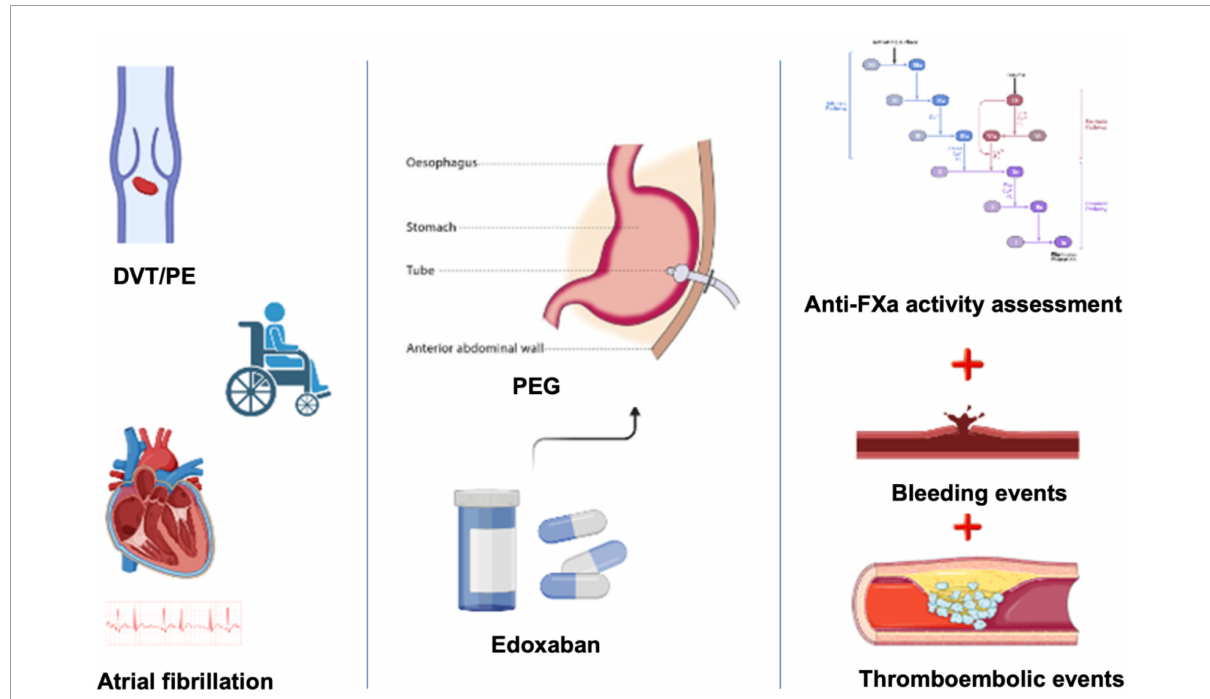
FIGURE1 The main features of the ORIGAMI study design. Patients with indication for long-term oral anticoagulation indication were enrolled; edoxaban (at approved dose) was administered through PEG; thromboembolic and bleeding events and anti-FXa activity were assessed at 1, 6, and 12 months. DVT/PE, deep vein thrombosis/pulmonary embolism; PEG, percutaneous endoscopic